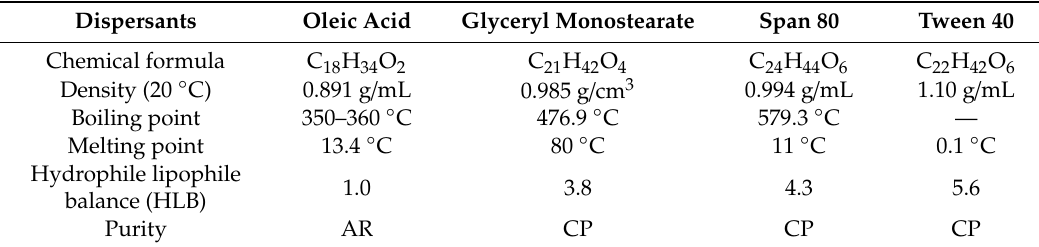
Table 2. Properties of dispersants.